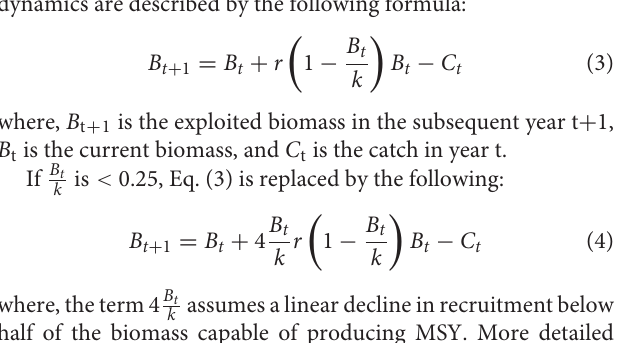
Frontiers in Marine Science |